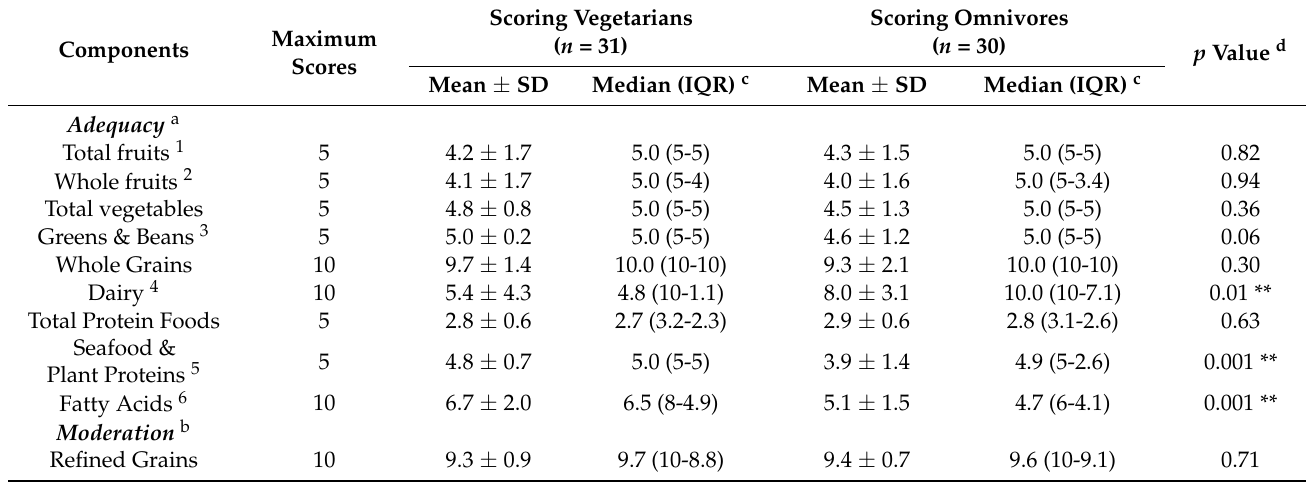
Figure 2. Proportions of participants ( a ) with an intake below 67% of the dietary reference values (DRV), ( b ) with an intake exceeding the DRV. Table 3. Healthy Eating Index-2015 (HEI-2015) of female students.